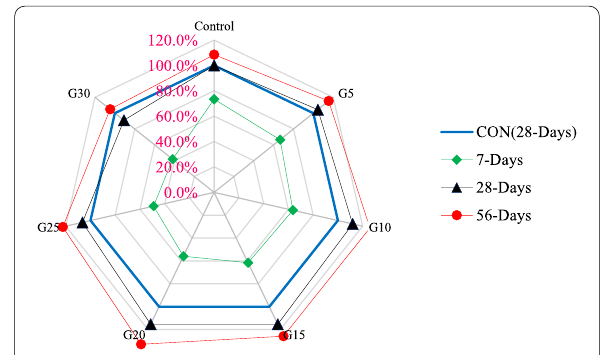
Fig. 11 Relative analysis of split tensile